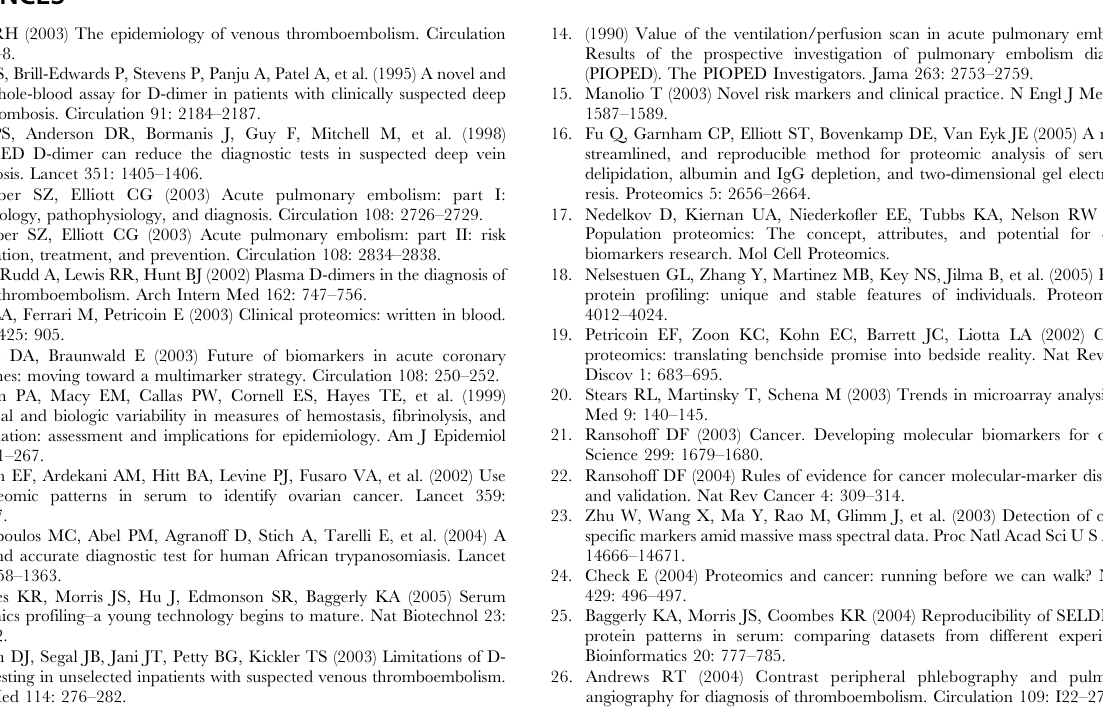
Figure S1 Computational pipeline used for analysis of direct MS data. Successive computational steps were performed using a pipeline to normalize, average and transform mass spectral data, perform ANN analysis and establish performance metrics.